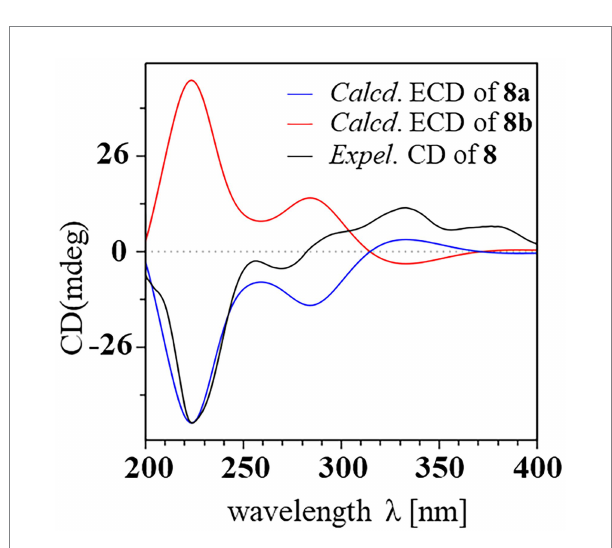
FIGURE 8 Experimental and calculated ECD spectra of compound 8